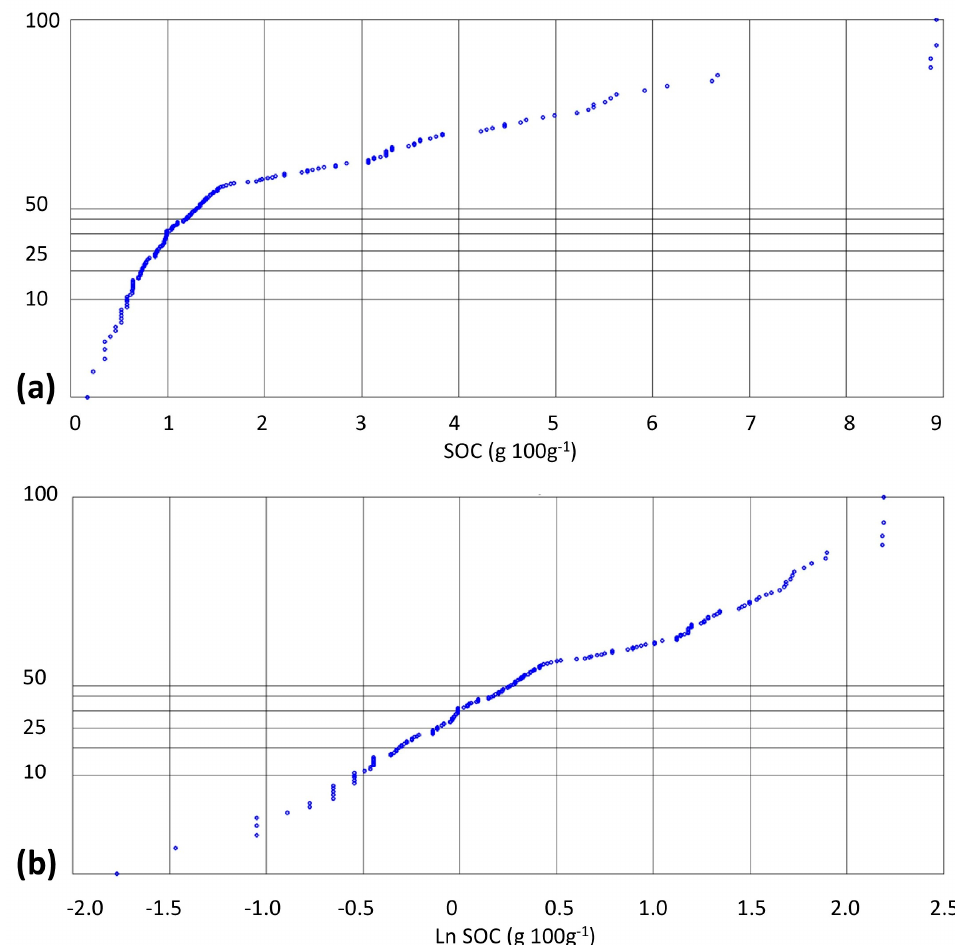
Figure 3. Normal probability plot of original SOC data ( a ) and natural logarithmic transformed ( b ) data. The skewness of the data distribution moved from 1.77 (original data) to 0.27 (Ln-transformed data). Table 2. Results of 10-fold cross-validation of the PLSR models for prediction of SOC, Clay, Silt, Sand, and CaCO 3 , using the spectra of the Neospectra Scanner, the whole spectrum of ASD Fieldspec, and the NIR bands 1350–2450 nm of ASD Fieldspec spectrum. PCs represent the number of principal components (or latent variables) used by the PLSR. *: the logarithmic transformation of SOC, to obtain a quasi-normal data distribution. The unit measure of all the variables was g·100 g − 1 . Neospectra Scanner (1350–2500 nm)